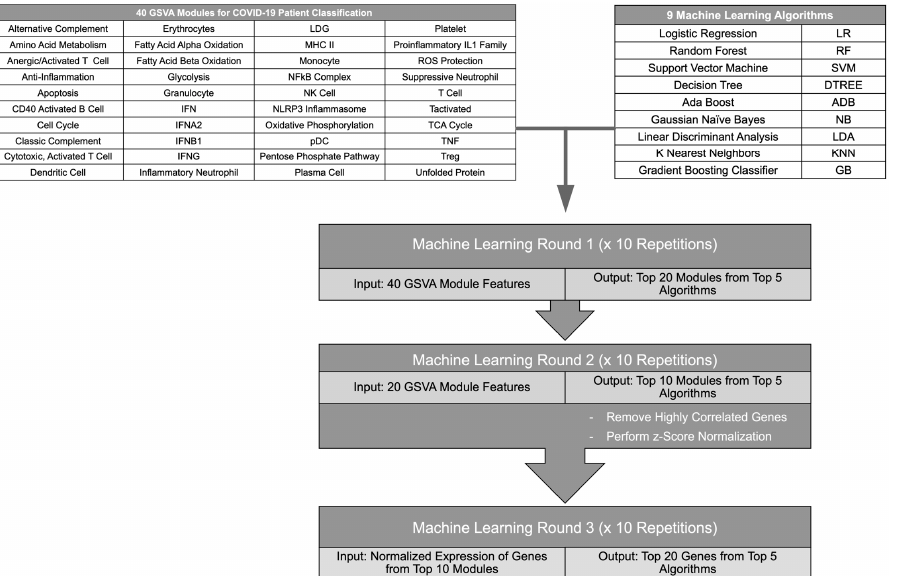
Figure 1. Flow diagram of the iterative ML pipeline. Graphic depicting steps in the iterative ML pipeline used for classification of COVID-19 patients. GSVA scores of gene modules representing immune cells and pathways were used as input for 9 different ML algorithms in 2 iterations after which a final ML iteration used z-score-normalized gene expression values. The flow chart was cre- ated in Microsoft Powerpoint.